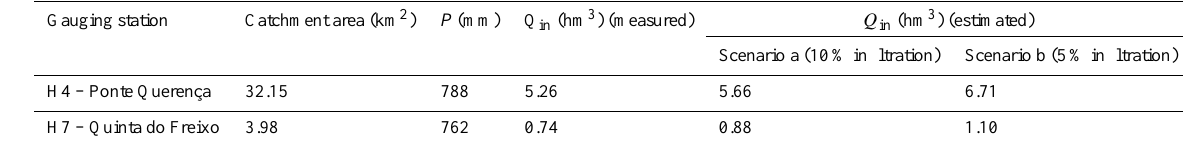
Table 2. Comparing upstream surface inflow to aquifer ( Q in ) from monitoring data with estimations resulting from Eq. (3). Gauging station